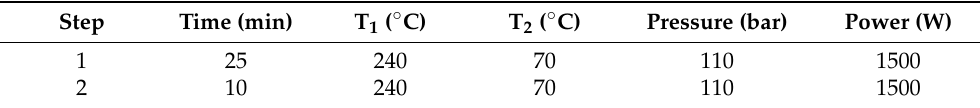
Table 6. Sample mineralization